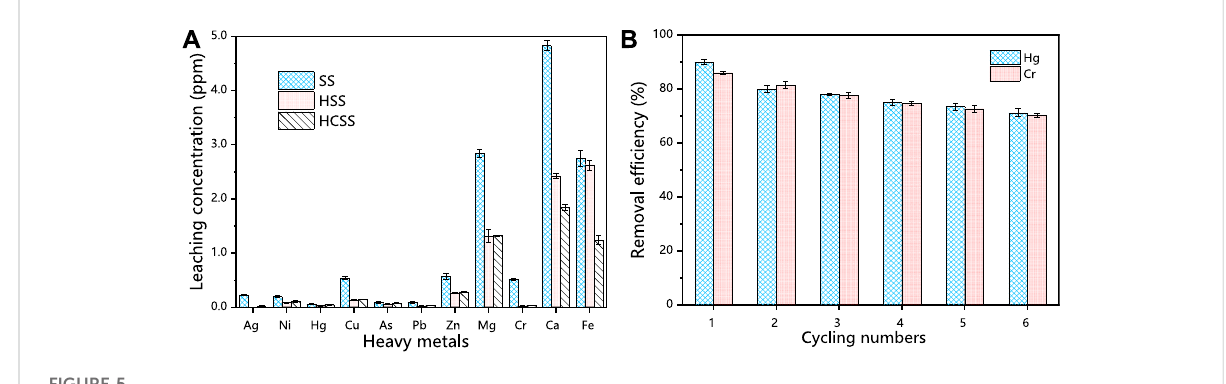
FIGURE 5 (A) Comparison of the different indigenous metal leaching concentration of SS, HSS, and HCSS. Conditions: sample volume: 10 ml; dosage: 100.0 g/L; reaction time: 48 h; pH 6.5; and temperature: 25 ° C. (B) Regeneration of